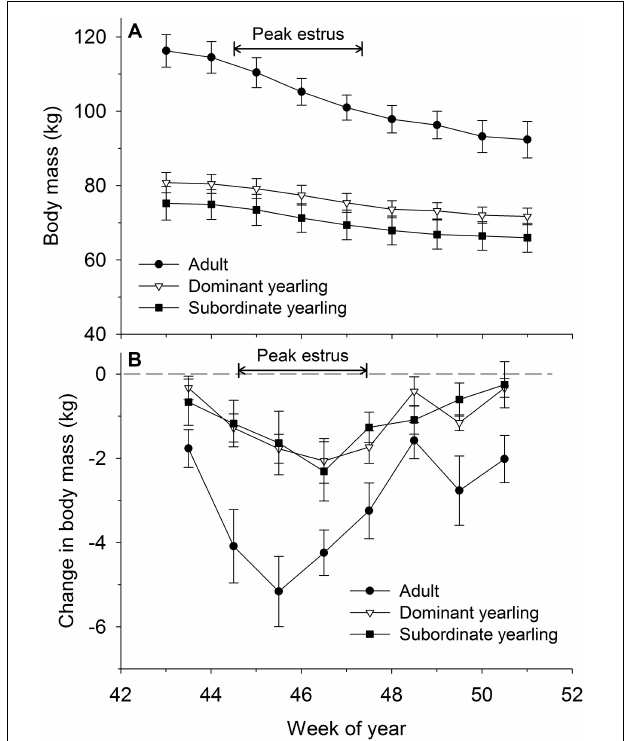
FIGURE 3 | Weekly (A) body mass (kg ± SE) and absolute change in body mass (B) between weeks (kg ± SE) for adult ( ≥ 4.5-years old; n = 12), dominant yearling (1.5-years old and adult male absent; n = 11), and subordinate yearling (1.5-years old and adult male present; n = 9) white-tailed deer during 2006–2008 and 2010–2011, Brookings, SD, United States. Weeks correspond to mid-October through mid-December. Weeks of peak estrus represent dates when 86% of estimated conception events